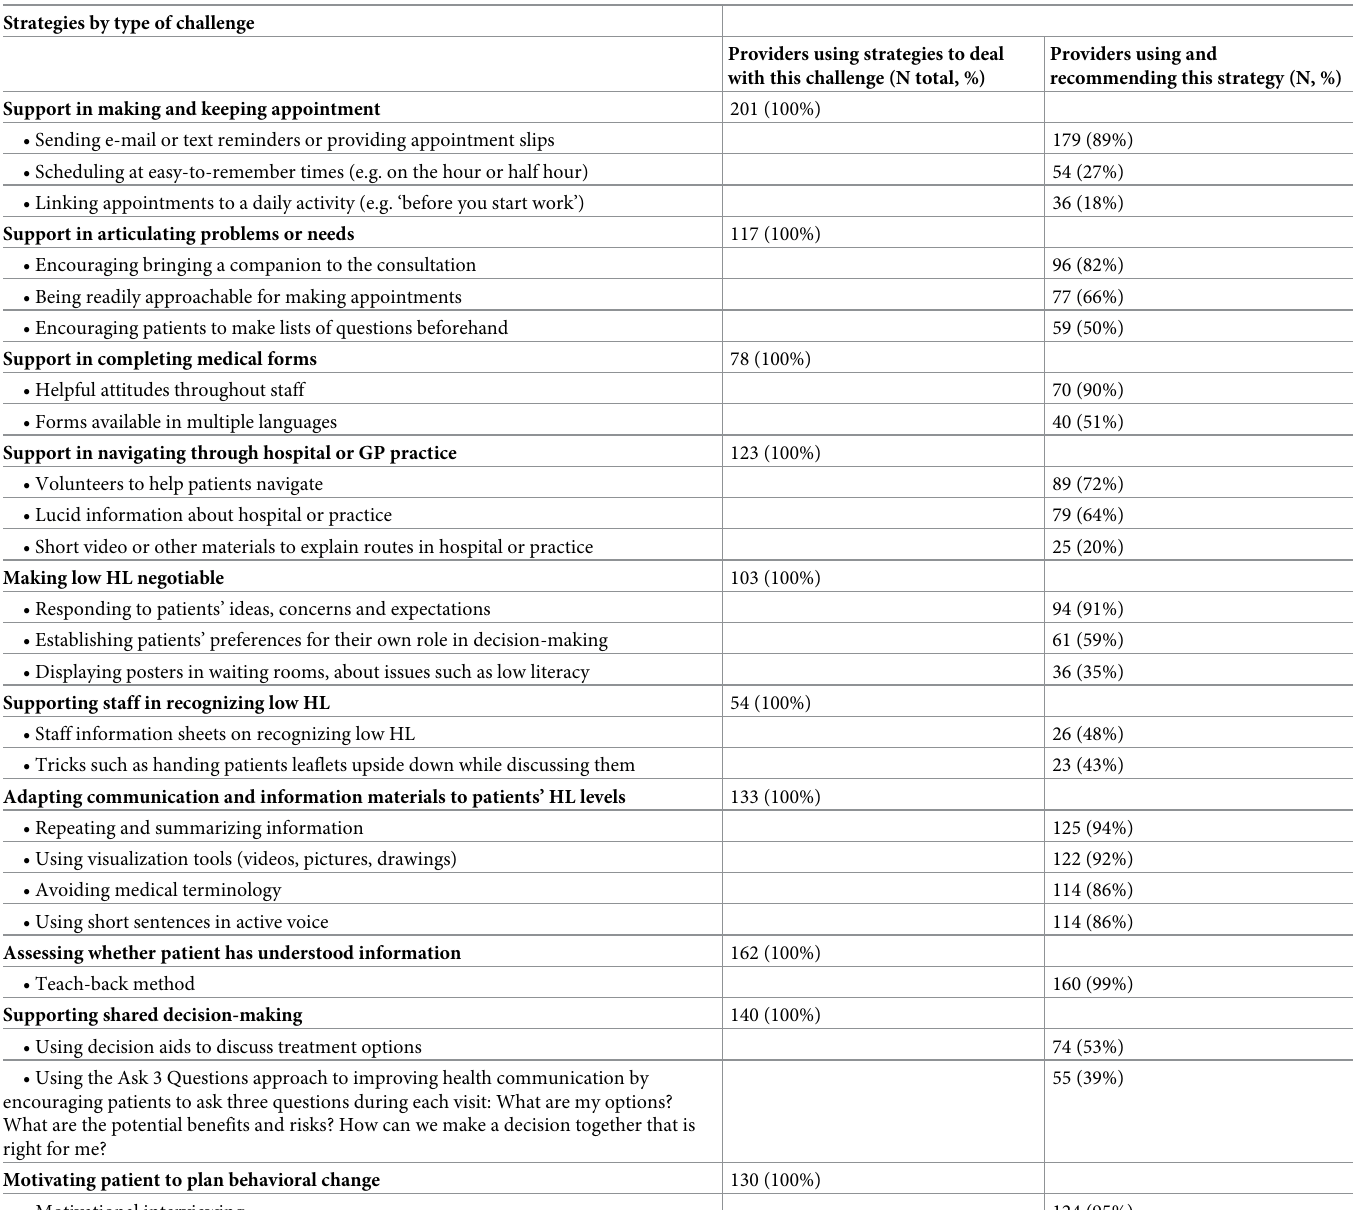
Table 6. Used and recommended strategies, differentiated by type of